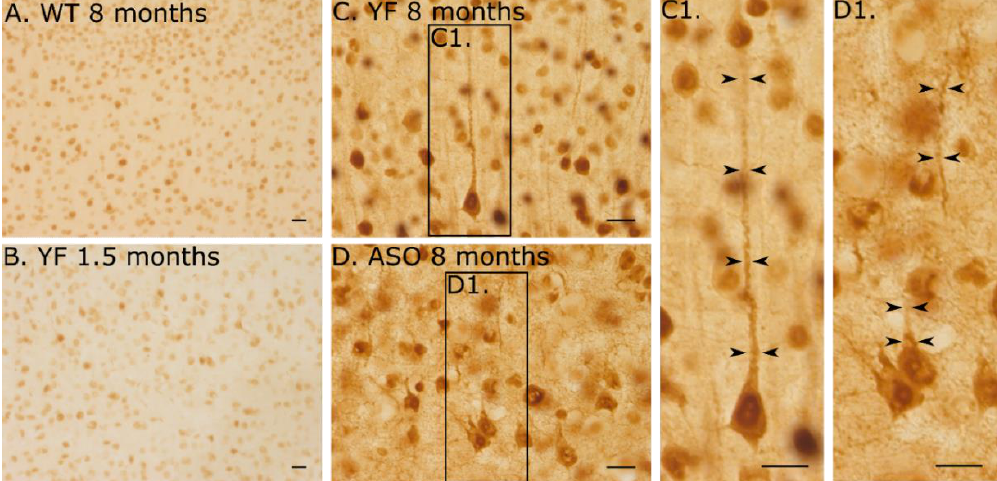
Figure 6. Phosphorylation in neocortical neurons of wildtype (WT), YF, and ASO brains . Immunolabelling of phosphorylated α -synuclein in cerebral cortex of ( A ). WT mice at 8 months. ( B ). YF at 1,5 months, ( C – C1 ). YF mice at 8 months, and ( D – D1 ). ASO mice at 8 months. Phosphorylated α -synuclein distributes to neuronal perikarya and neurons throughout the cerebral cortex even in the WT mouse. By 1.5 months, neurons are seen with a marked increase in labelling of neuronal nuclei and surrounding cytoplasm ( B ). ( C ) At 8 months, phosphorylation of α -synuclein extends widely into the dendrites ( C ), which is clearly observed at high-power magnification (( C1 ) larger magnification of square in ( C ). ( D ) ASO mice also have increased phosphorylation of α -synuclein, which extends into proximal arborizations of the cytoplasm, though not to the same extent as the YF mice. ( D1 ) is larger magnification of square in ( D ). Scale bars: ( A , B ) , 50 μm. ( C ) , 30 μm, ( C1 ), 10 μm, ( D ) , 30 μm, ( D1 ) , 10 μm.